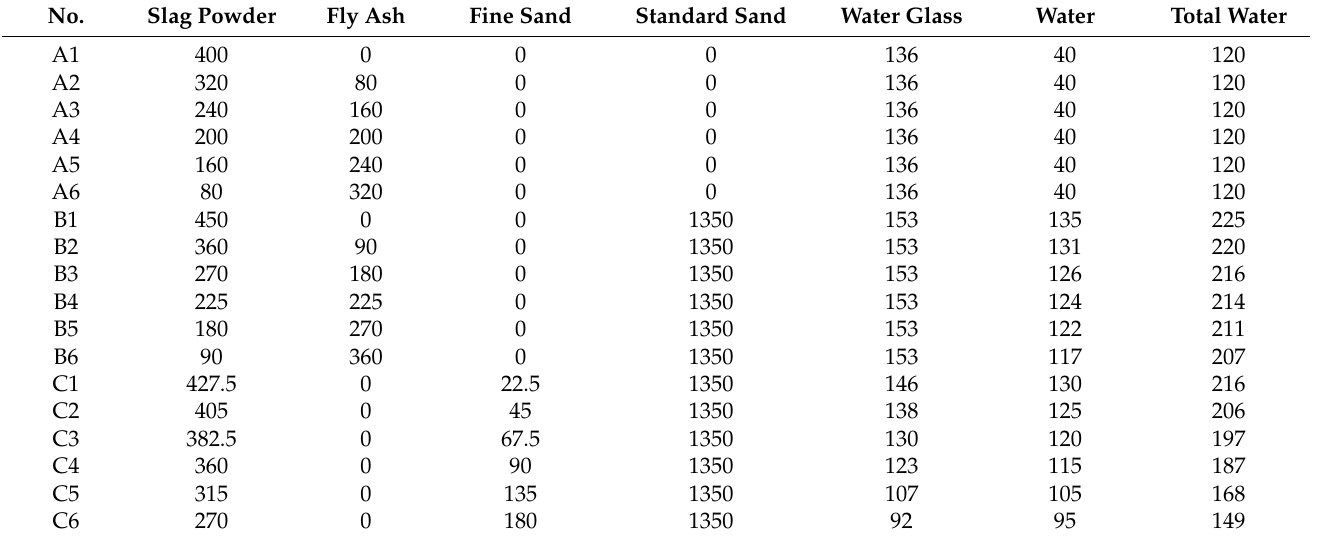
Table 1. Mix ratio of strength experiment (g).